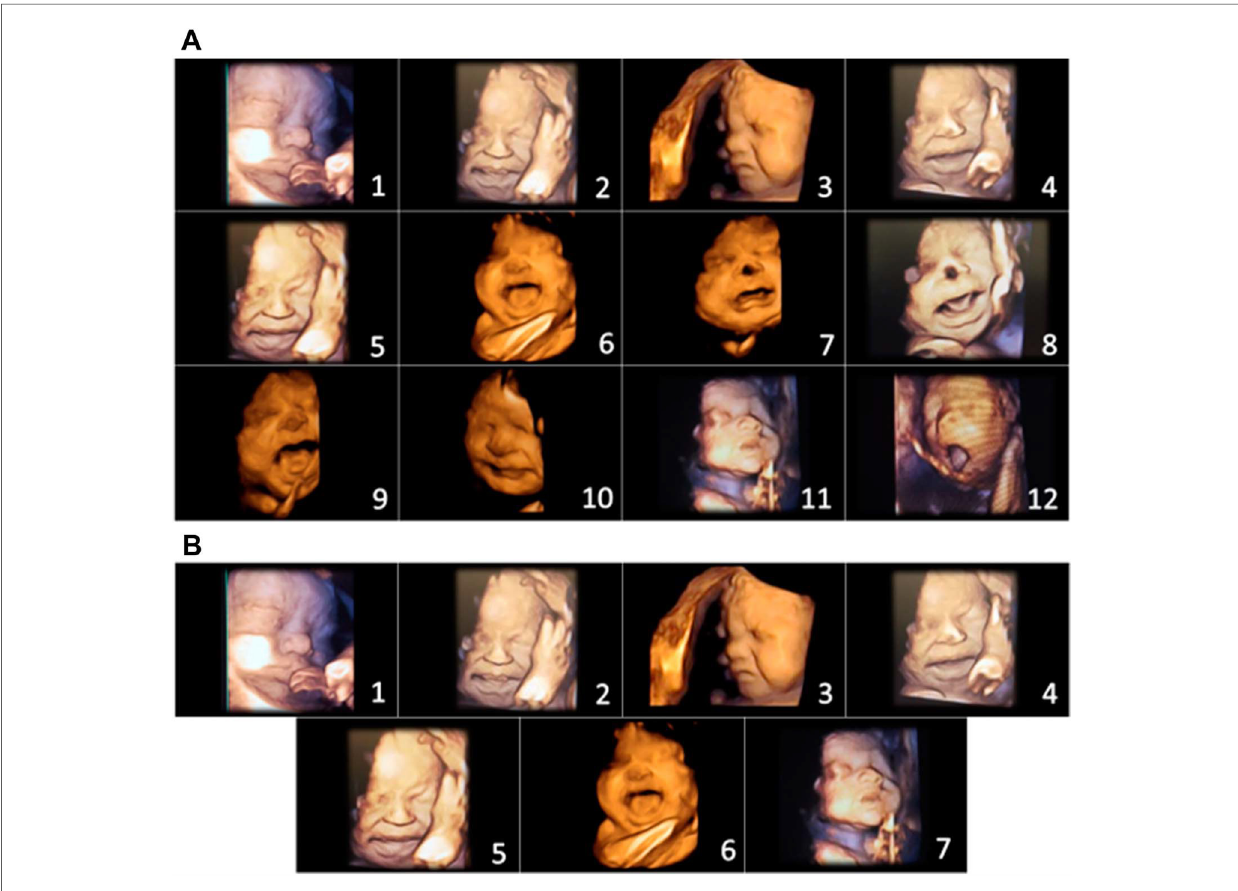
FIGURE 7 Pain assessment tool for third trimester fetuses during anesthetic injection into the thigh during fetal surgery (58). ( A ) Initial items from neonatal facial coding system and 2 supplementary items. 1. Brow lowering. 2. Eyes squeezed shut. 3. Deepening of the nasolabial furrow. 4. Open lips. 5. Horizontal mouth stretch. 6. Vertical mouth stretch. 7. Lip purse. 8. Taut tongue. 9. Tongue protrusion. 10. Chin quiver. 11. Neck de fl ection 12. Yawning. ( B ) Final items from the Fetal-5 Scale. 1. Brow lowering. 2. Eyes squeezed shut. 3. Deepening of the nasolabial furrow. 4. Open lips. 5. Horizontal mouth stretch. 6. Vertical mouth stretch. 7. Neck de fl ection.